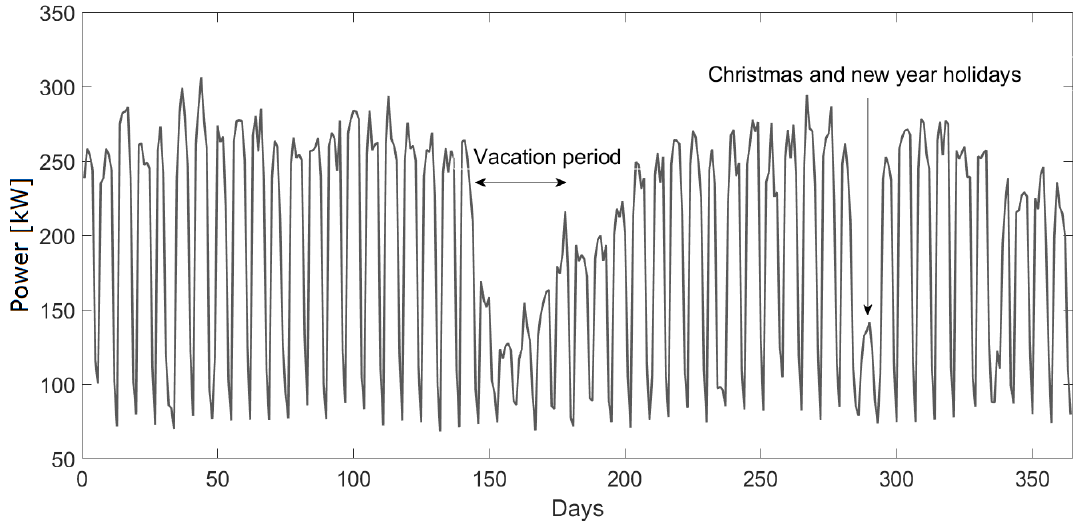
Figure 5. Electricity consumption: Universidad Politécnica Salesiana (9 March 2017–8 March 2018).